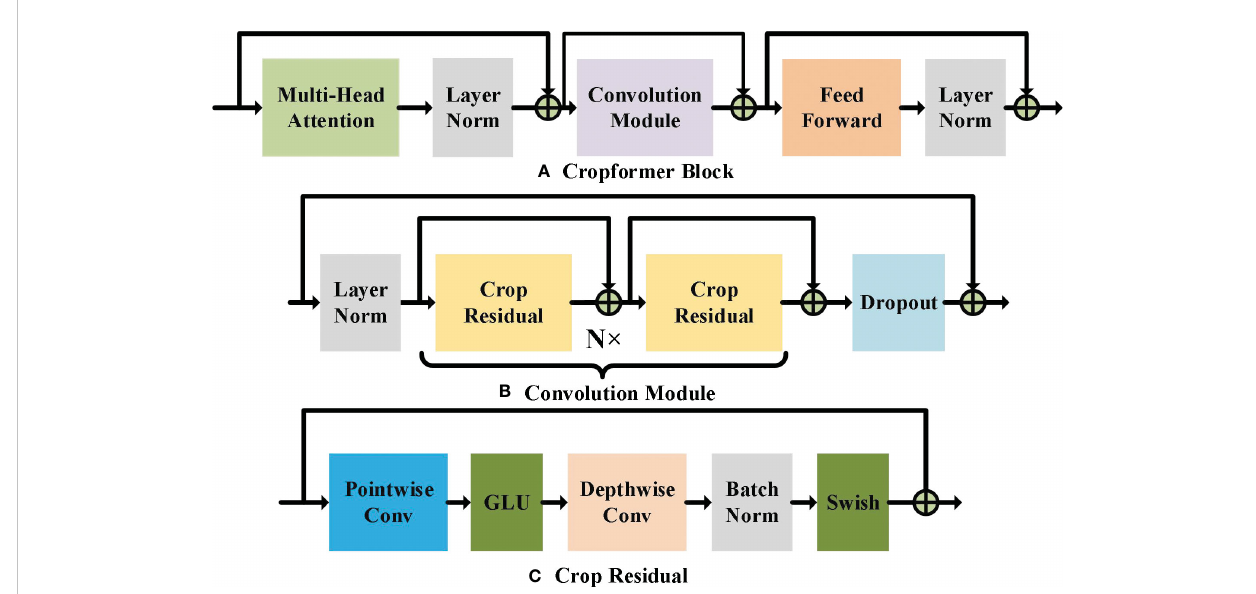
FIGURE 2 Cropformer Block, Convolution Module and Crop Residual detailed architecture. In (A) MHAL extracts global information, CM extracts local information, FFN will get information further enhanced, and LN is used for layer normalization to prevent model over fi tting. (B) shows the two-start residual connection, and dropout is used to speed up the model training and prevent over fi tting. GLU and Swish are the two learnable activation functions in (C) , and BN is used for batch normalization to prevent model over fi